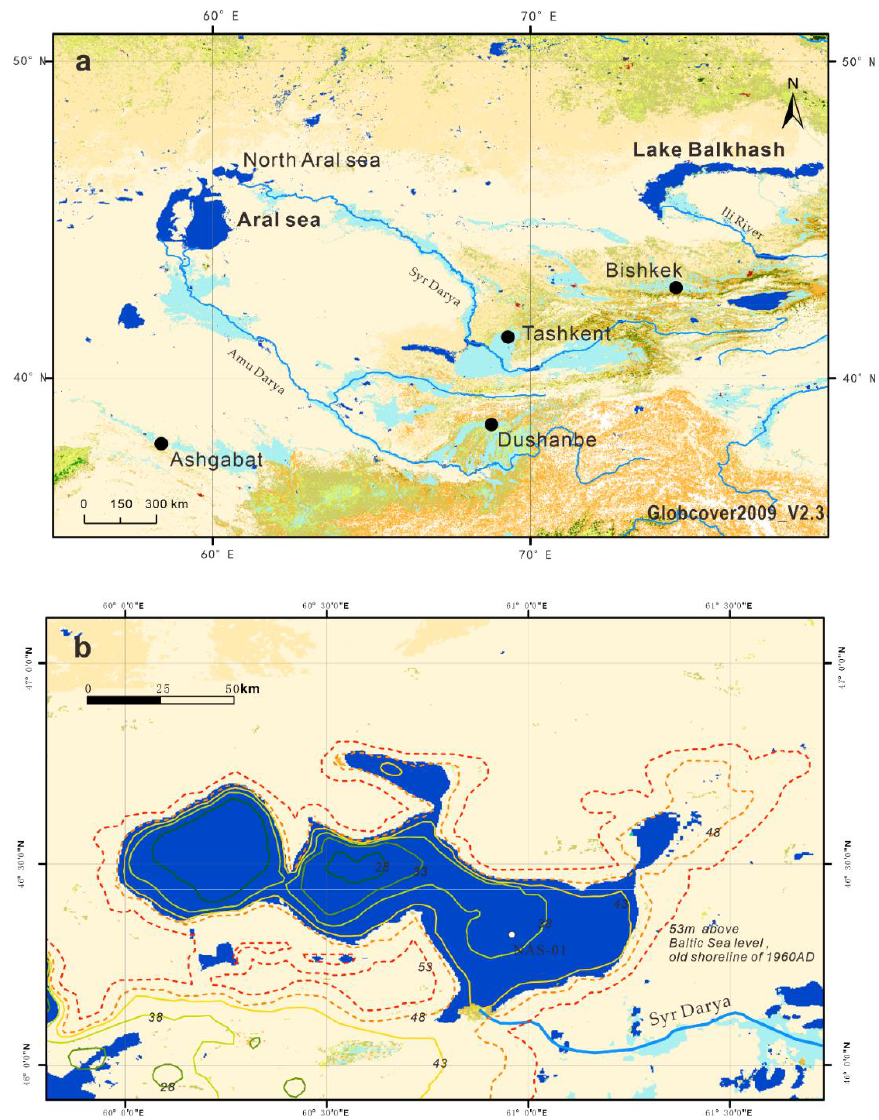
Figure 1. ( a ) Location of the Aral Sea in Central Asia; and ( b ) topographic map of North Aral Sea and the sampling location of the sediment core (NAS-01) denoted by the white